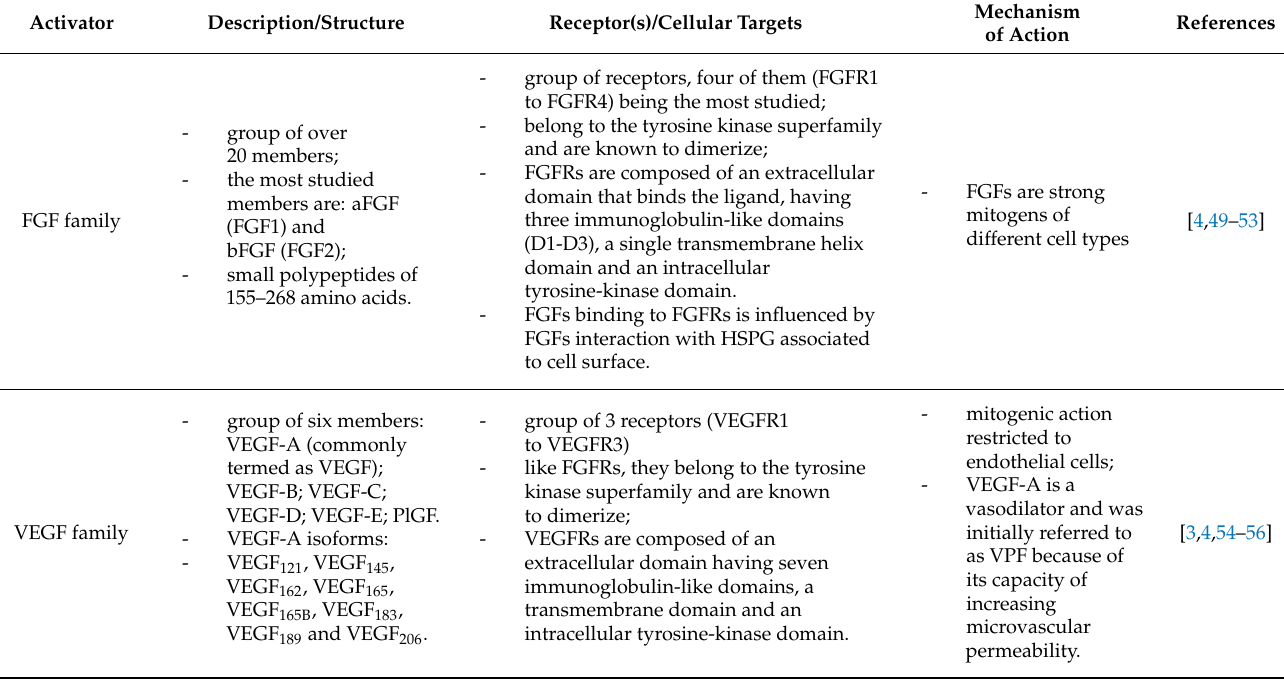
Table 1. Endogenous angiogenesis